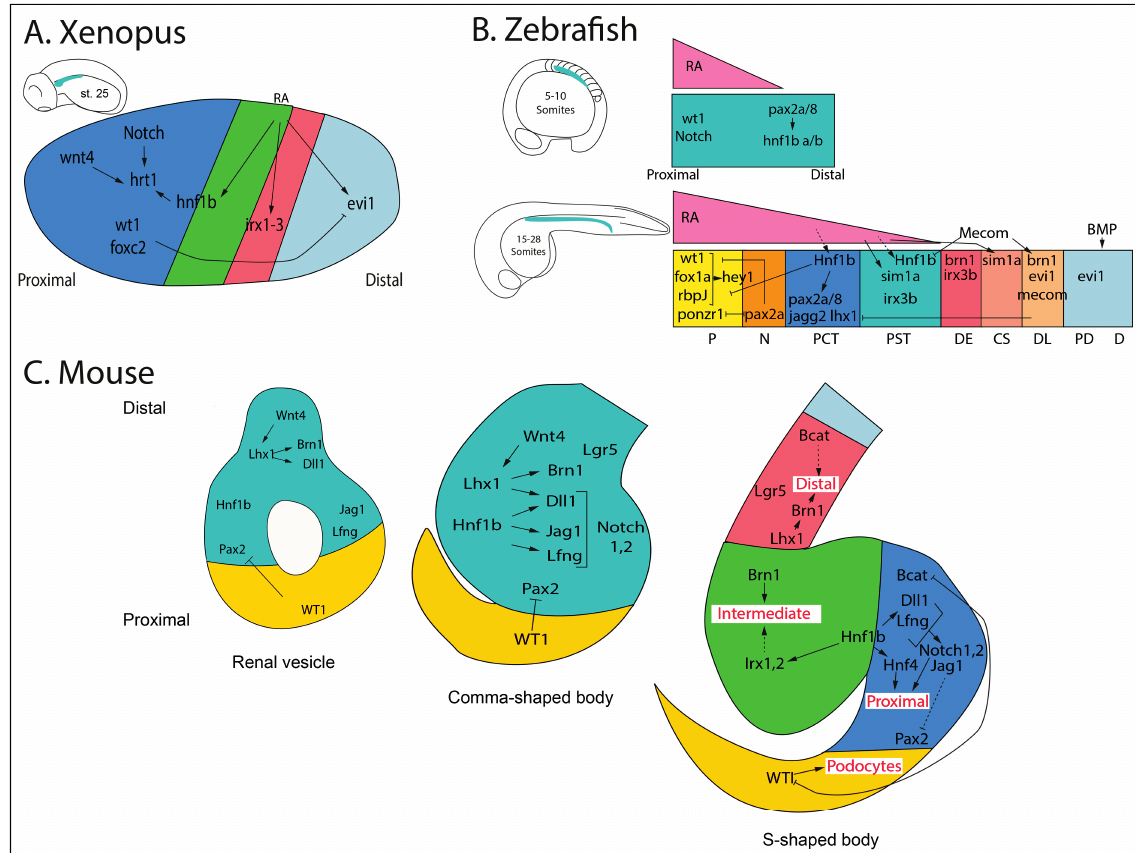
Figure 3. Genetic pathways of nephron segmentation in Xenopus ( A ), zebrafish, ( B ) and mouse ( C ). Colors are the same as described in Figure